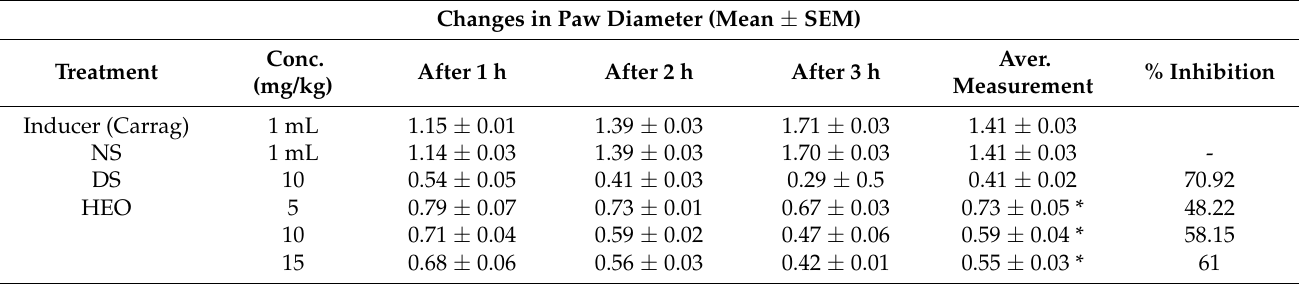
Table 5. Anti-inflammatory activity of crude oils of S. edelbergii .